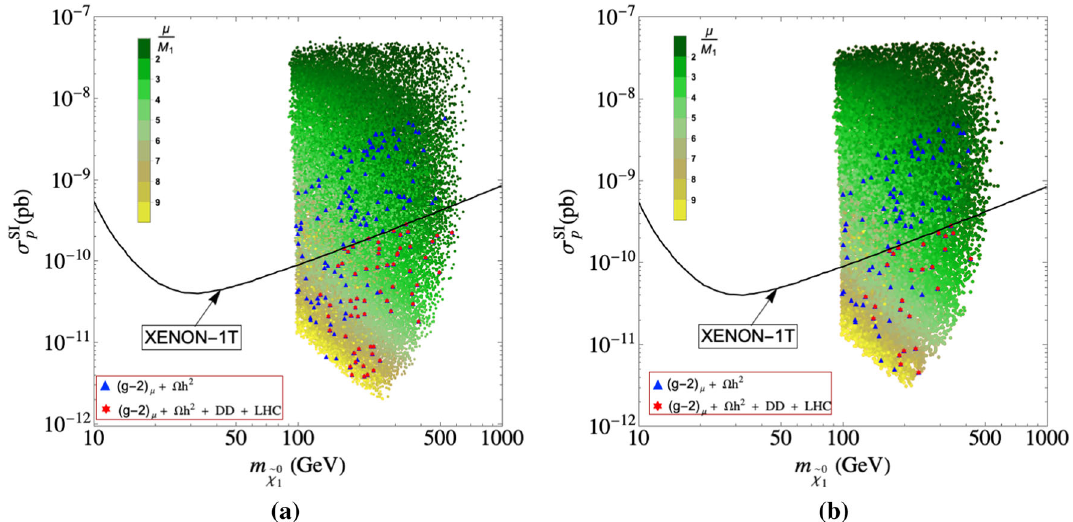
Fig. 4 Scan results in the m ˜ χ 0 - σ SI p plane for current (left) and anticipated future limits (right) from ( g − 2 ) μ . The color coding of the points denotes 1 μ/ M 1 and the black line indicates the DD limits (see text). In blue (red) we show the points fulfilling the relic density (and additionally the LHC) constraints